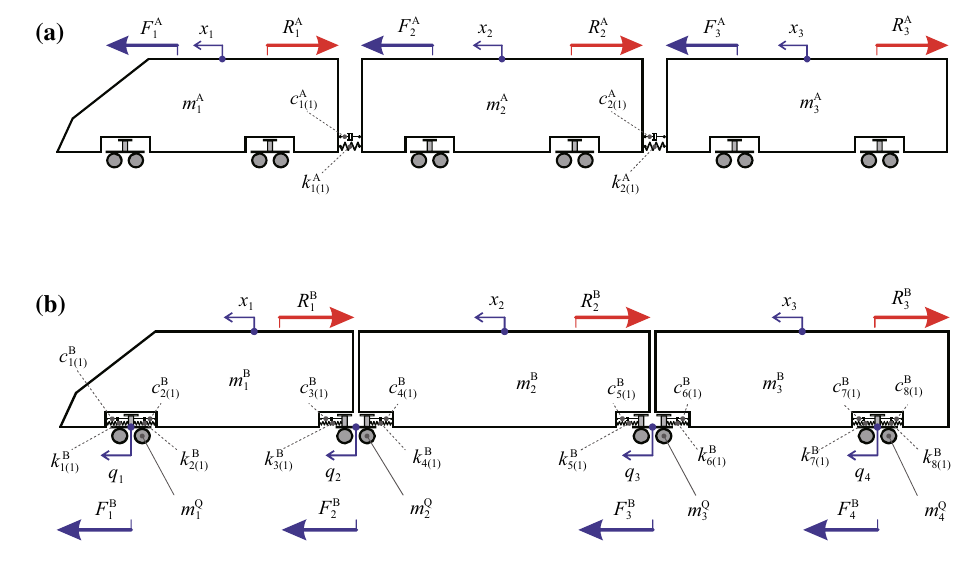
Fig. 3 LTD models of MUTs: a model A; b model